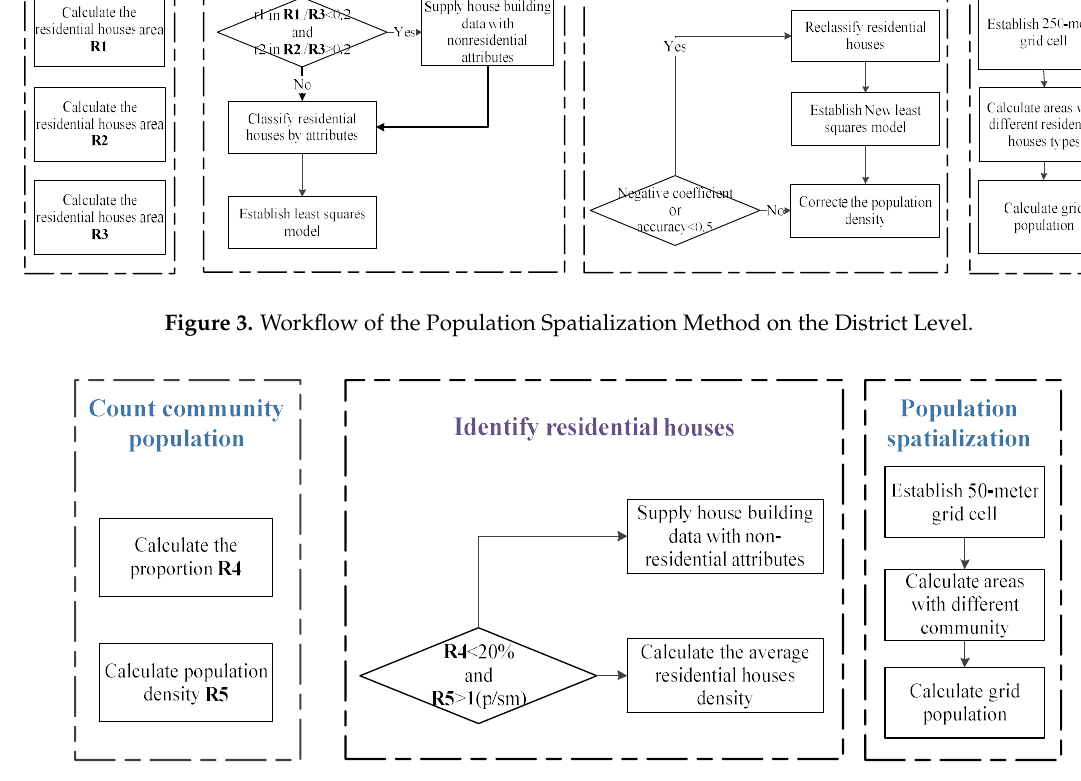
Figure 4. Workflow of the Population Spatialization Method on the Street Level.